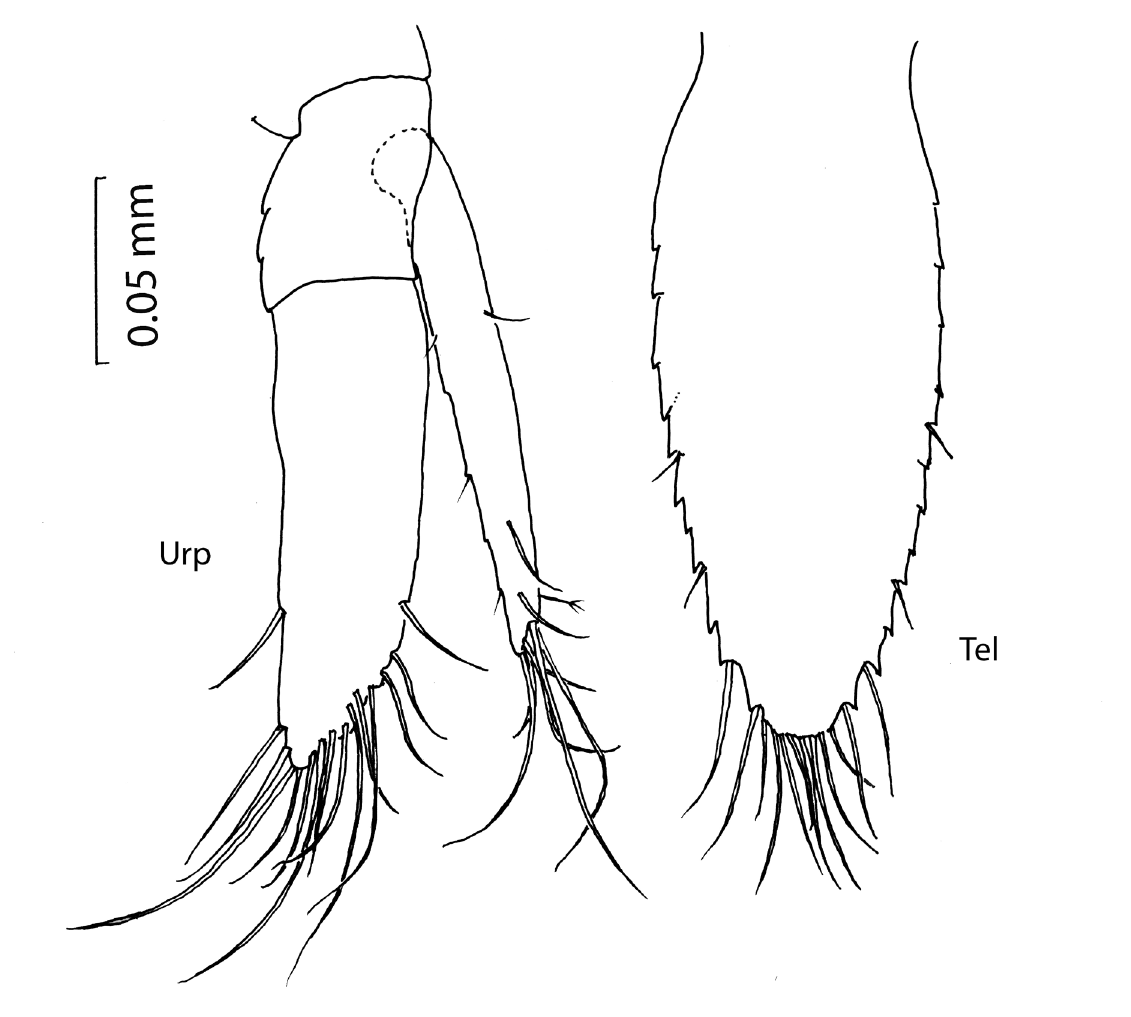
Fig. 5. Hyssura reptans sp. nov., ♂, holotype . Abbreviations: Urp = uropod; Tel =